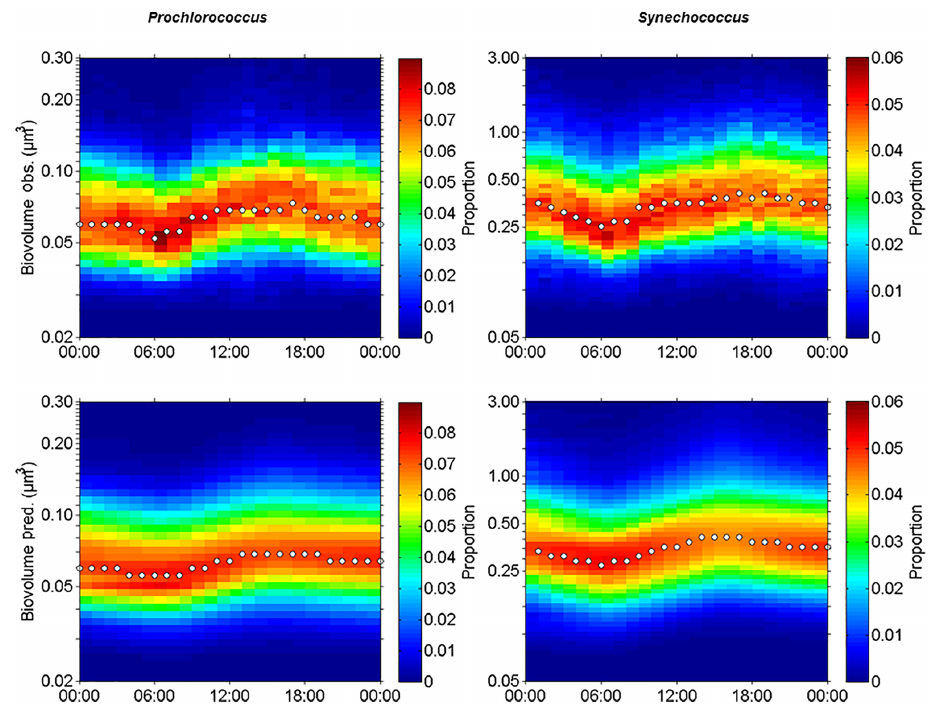
Figure 9. Observed (Obs.) and predicted (Pred.) hourly normalized cell size distributions (in µm 3 ) of Prochlorococcus and Synechococcus from 5 November 00:00 to 6 November 00:00 (local time). White dots indicate the median size of the populations.